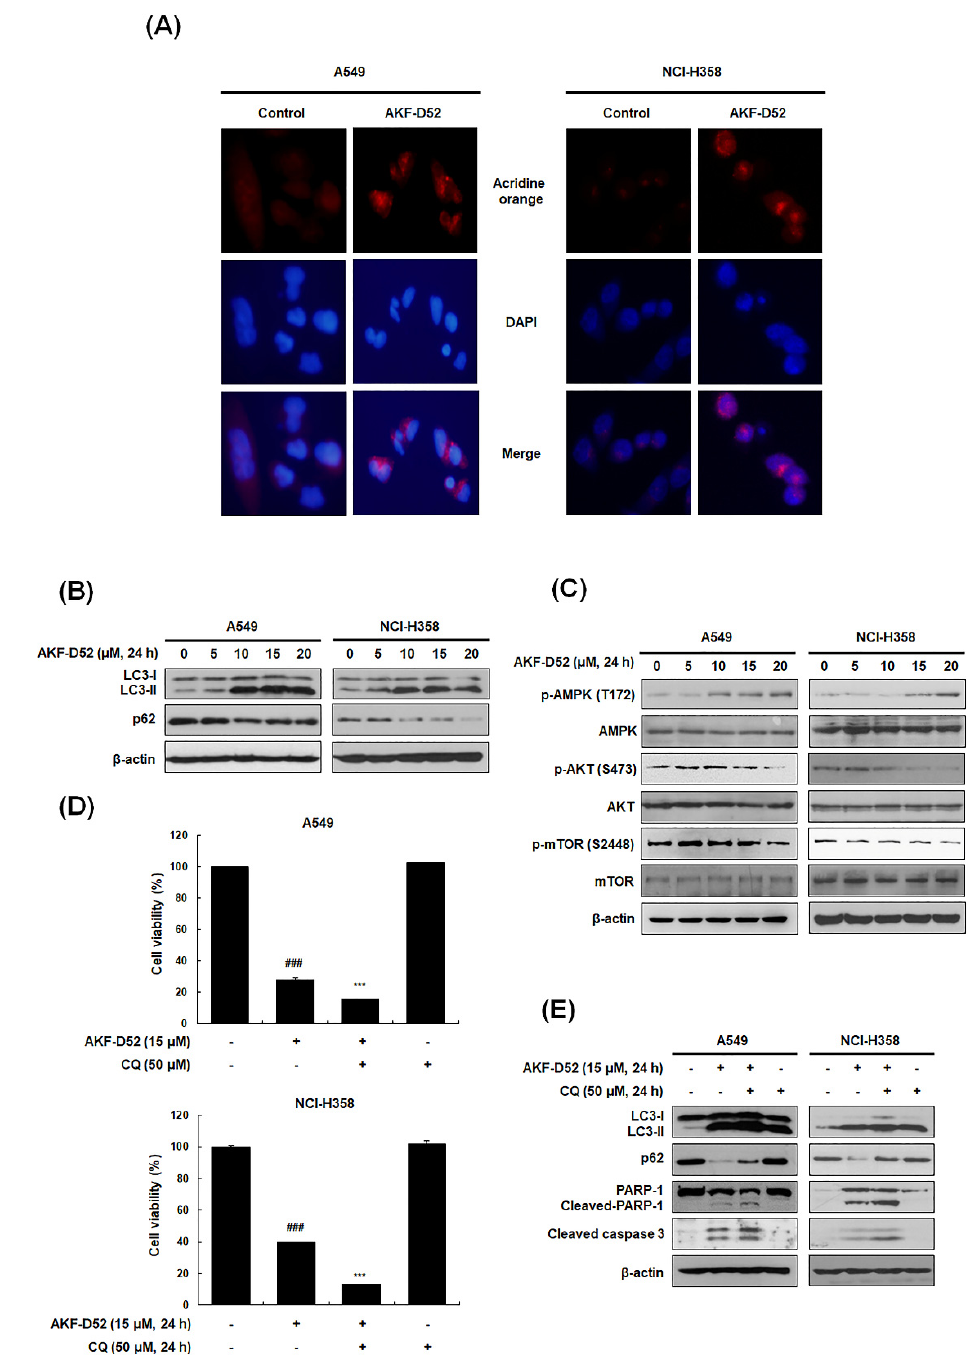
Figure 5. The effects of AKF-D52-induced cytoprotective autophagy on apoptosis in NSCLC cells. A549 and NCI-H358 cells were treated with AKF-D52 (15 μ M) for 24 h. ( A ) AKF-D52-treated cells were co-stained with acridine orange and DAPI. Autophagy vacuoles and nuclei were detected by a microscope. ( B , C ) Cell lysates were prepared, and Western blot analysis was performed, as described in the Materials and Methods section. ( D ) After pretreatment with CQ for 1 h, cells were treated with AKF-D52 (15 μ M) for 24 h. Cell viability was measured using the MTT assay. ( E ) Cells were lysed, and Western blot analysis was performed, as described in the Materials and Methods section. β -actin was used as an internal control. Data are presented as the mean ± SD of three independent experiments. ### p < 0.001 vs. the untreated control group, *** p < 0.001 vs. the AKF-D52-treated group.